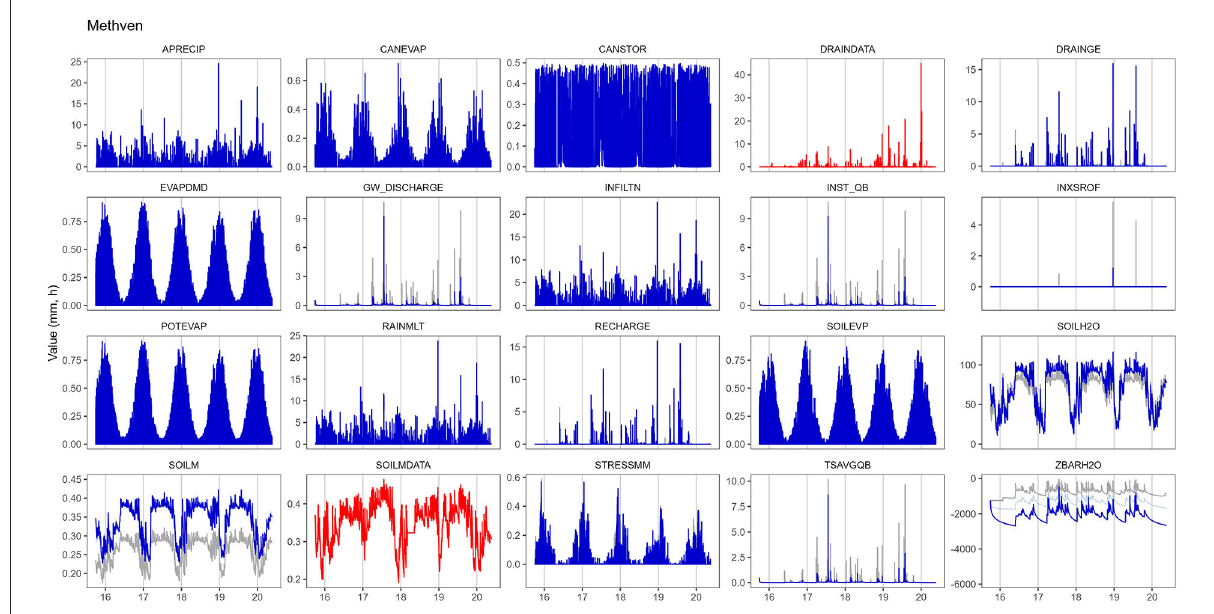
FIGUREA2 TopNet model simulations calibrated to Methven soil water content and drainage data, with calibration in dark blue, observation data in red, S-map-hydro in grey, and median of the ensemble simulation in medium